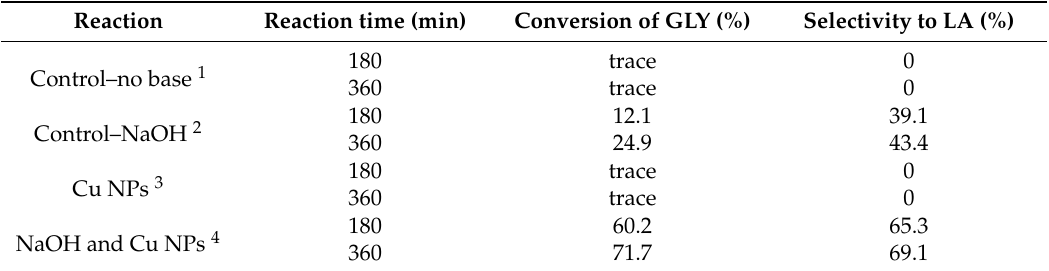
Table 1. Conversion of glycerol without catalyst and with addition of NaOH and Cu NPs.